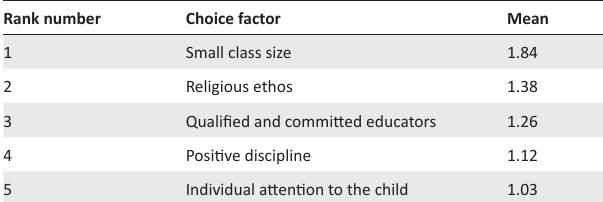
TABLE 5: Top five choice factors identified. Rank